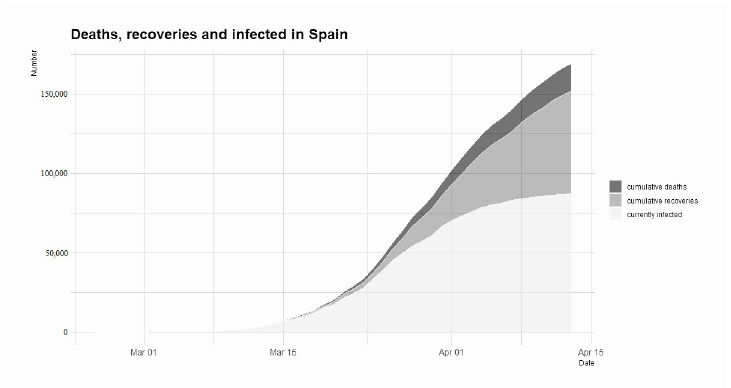
Figure 3. Cumulative number of infections, recoveries and deaths in Spain.